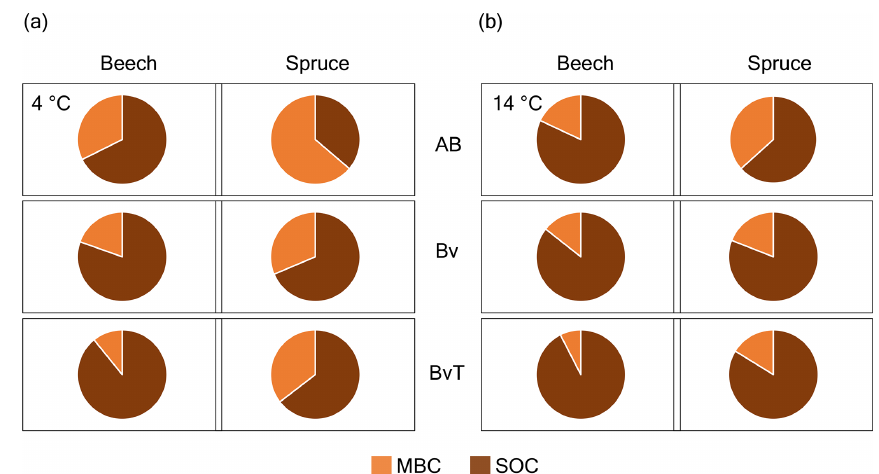
Figure 3. Proportion of fixed carbon recovered in MBC and SOC pools of the beech and spruce soils. The pie charts show the relative proportions of microbially derived 13 CO 2 into MBC (orange fractions) and SOC (brown fractions) pools expressed as a percentage of the total fixed carbon after 21d of incubation with 2% 13 CO 2 for soils incubated at (a) 4 and (b) 14 ◦ C across three horizons (AB, Bv, BvT) in beech and spruce soils. Values are the mean of three replicate incubations.